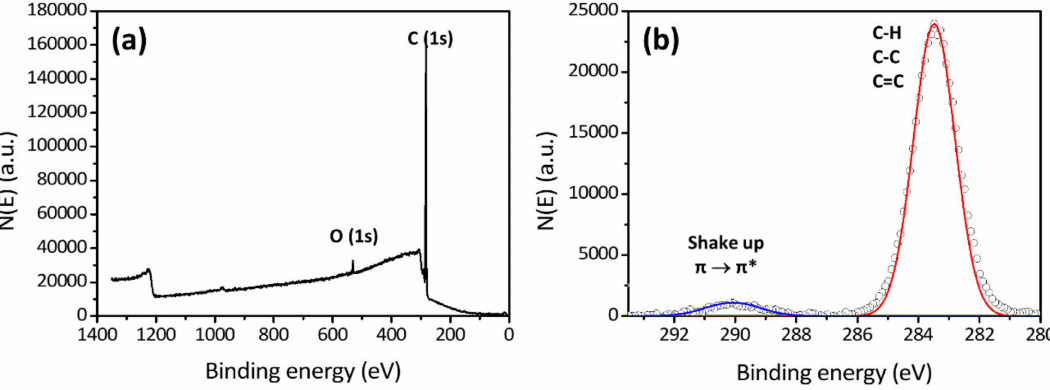
Figure 1. X-ray photoelectron spectroscopy (XPS) ( a ) survey spectrum and ( b ) C(1s) multiplex spectrum of polystyrene synthesized by atom transfer radical